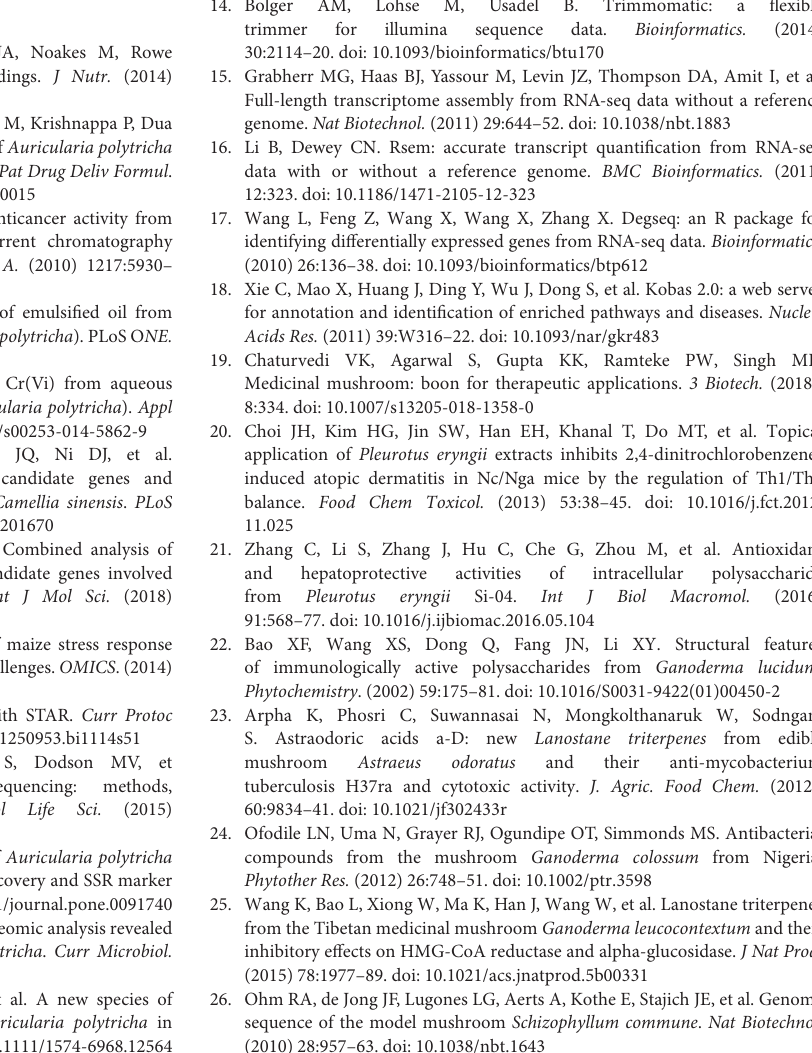
Supplementary Table 11 | Primers used in this